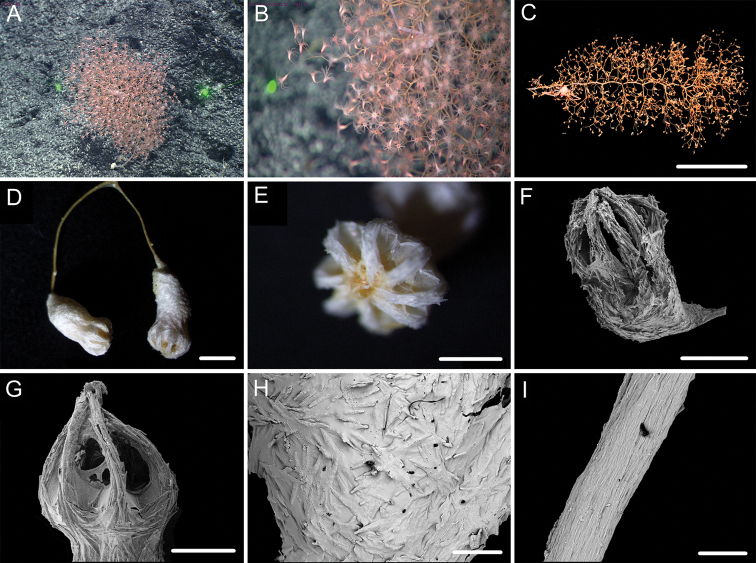
External morphology and polyps of Chrysogorgia
carolinensis sp. nov. A the holotype in situB close-up branches in situC the holotype after collection D two polyps under a light microscope E tentacles under a light microscope F a single polyp under SEMG upper part of a polyp under SEMH basal polyp body under SEMI coenenchyme under SEM. Scale bars: 10 cm (B); 2 mm (D); 1 mm (E–G); 300 μm (H); 100 μm (I).